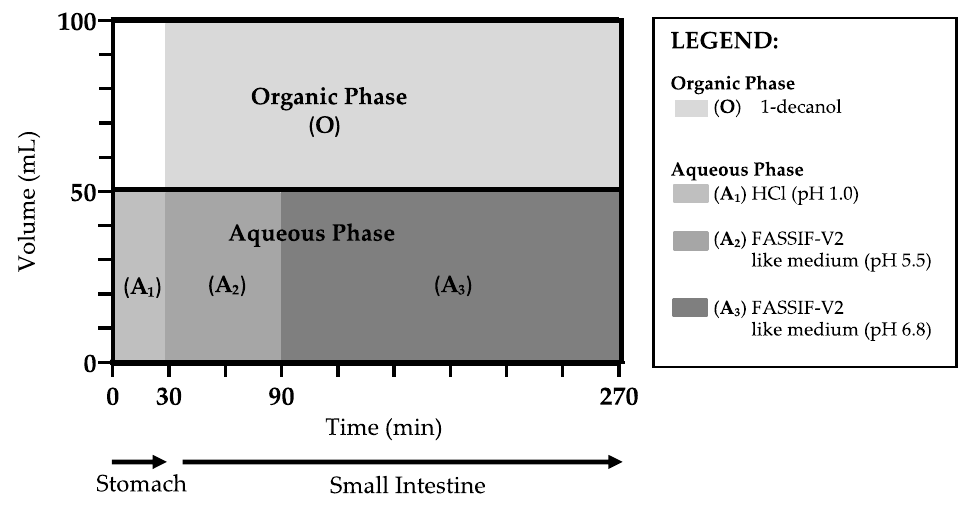
Figure 2. Media setup of the biphasic dissolution model BiPHa+.